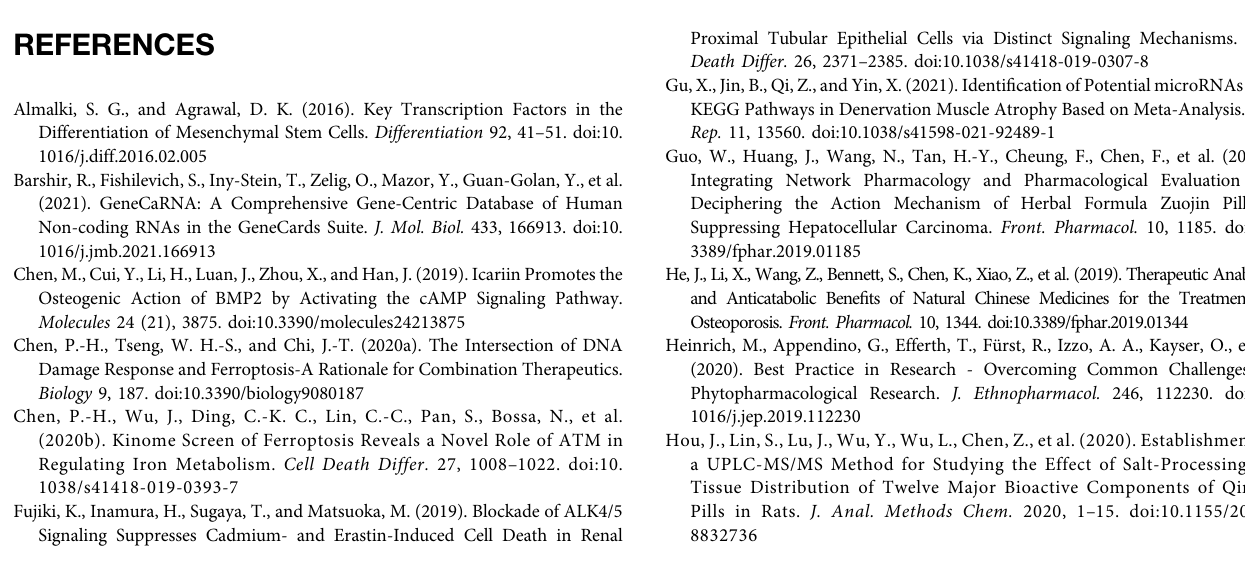
Supplementary Figure S1 | Potential molecular mechanisms and functional enrichment analysis of QEP-OP common targets. (B) Functional enrichment Analysis based on 121 common target- proteins. (C) The network of different GO items. (D) The PPI network of 121 targets-related